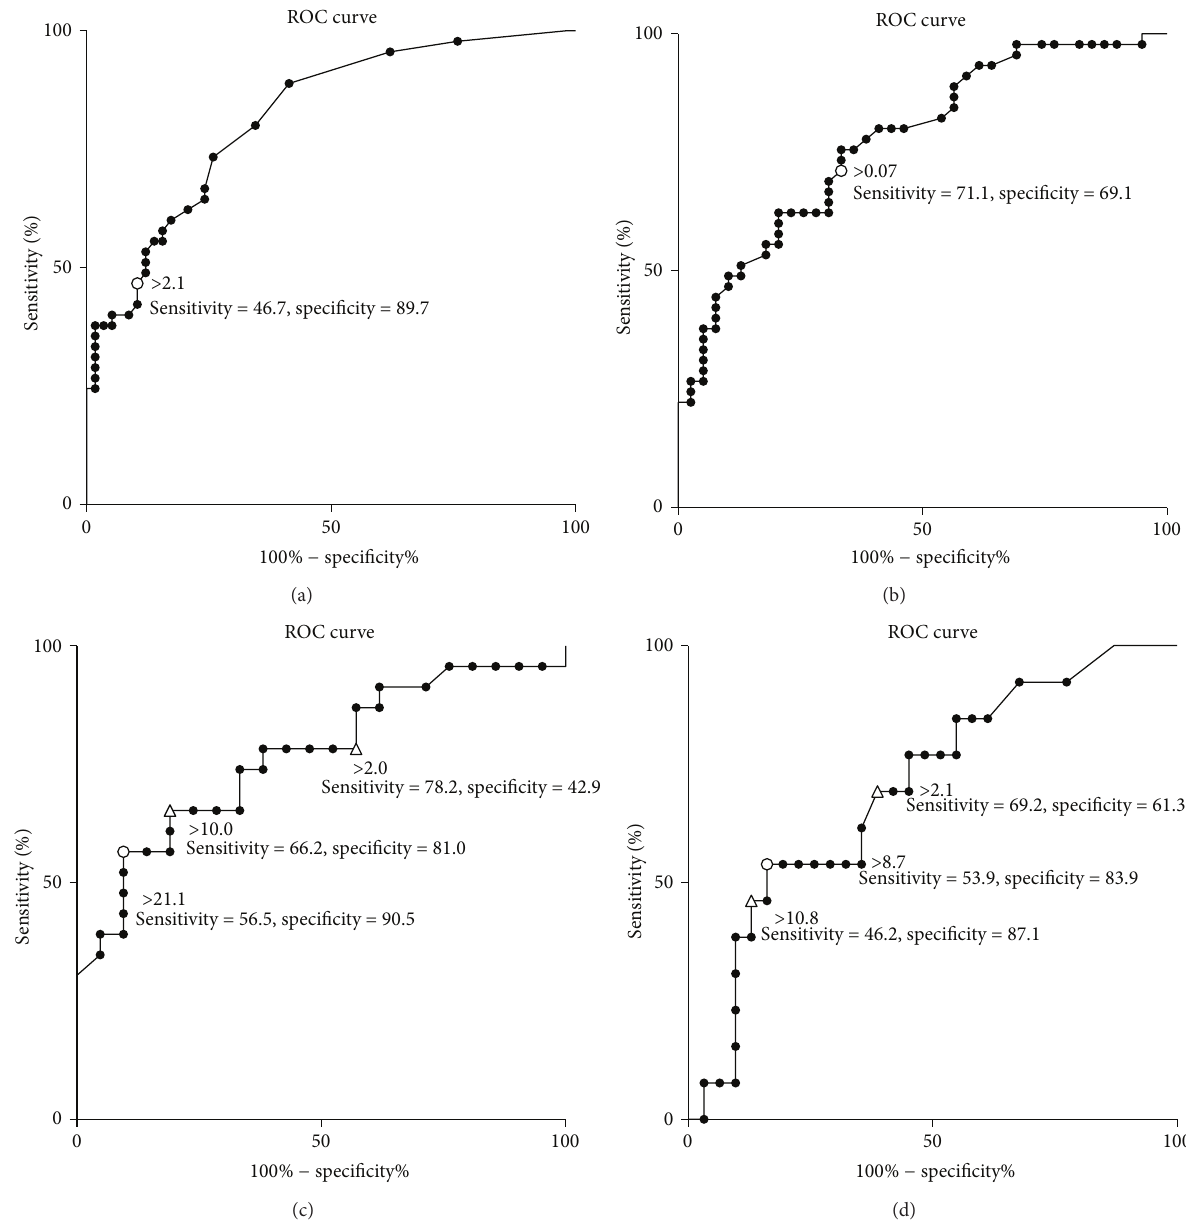
Figure3:ROCanalysisfordifferentantibodies.(a)and(b)ROCanalysisbetweenPTBpatientsandHCforanti-TBGLIgAandanti-LAMIgG, respectively; (c) ROC analysis between cavities positive and negative subjects for anti-TBGL IgG; (d) ROC analysis between bronchiectasis positive and negative subjects for anti-TBGL IgA. Circle : estimated optimal cutoff according to Youden’s index; triangle : arbitrary